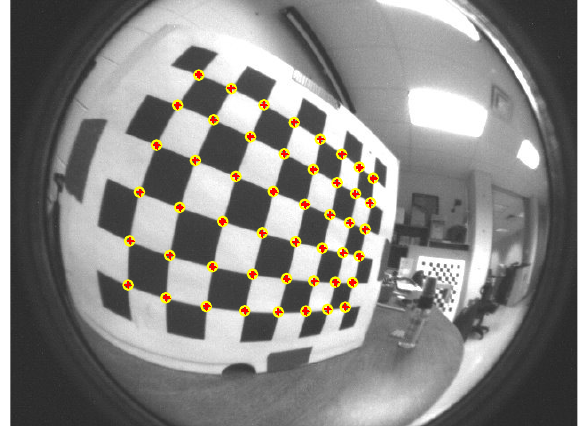
Figure 8: The re-projection of the corner points on calibration pattern on Point Grey’s Firefly camera equipped with Fujinon YV fisheye lenses. The yellow circles are the detected corner points while the red plus sign the re-projected corner